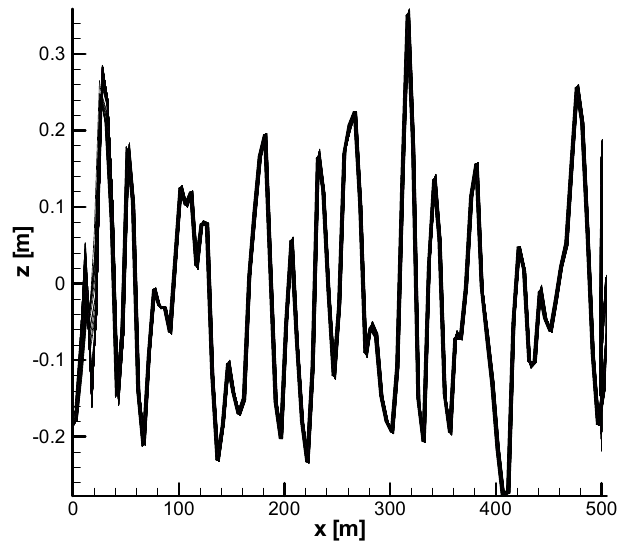
Figure 34. Trajectory beam in lateral view, case 2—detail B. Figure 35 shows a trajectory beam in a horizontal plane corresponding to the second case.